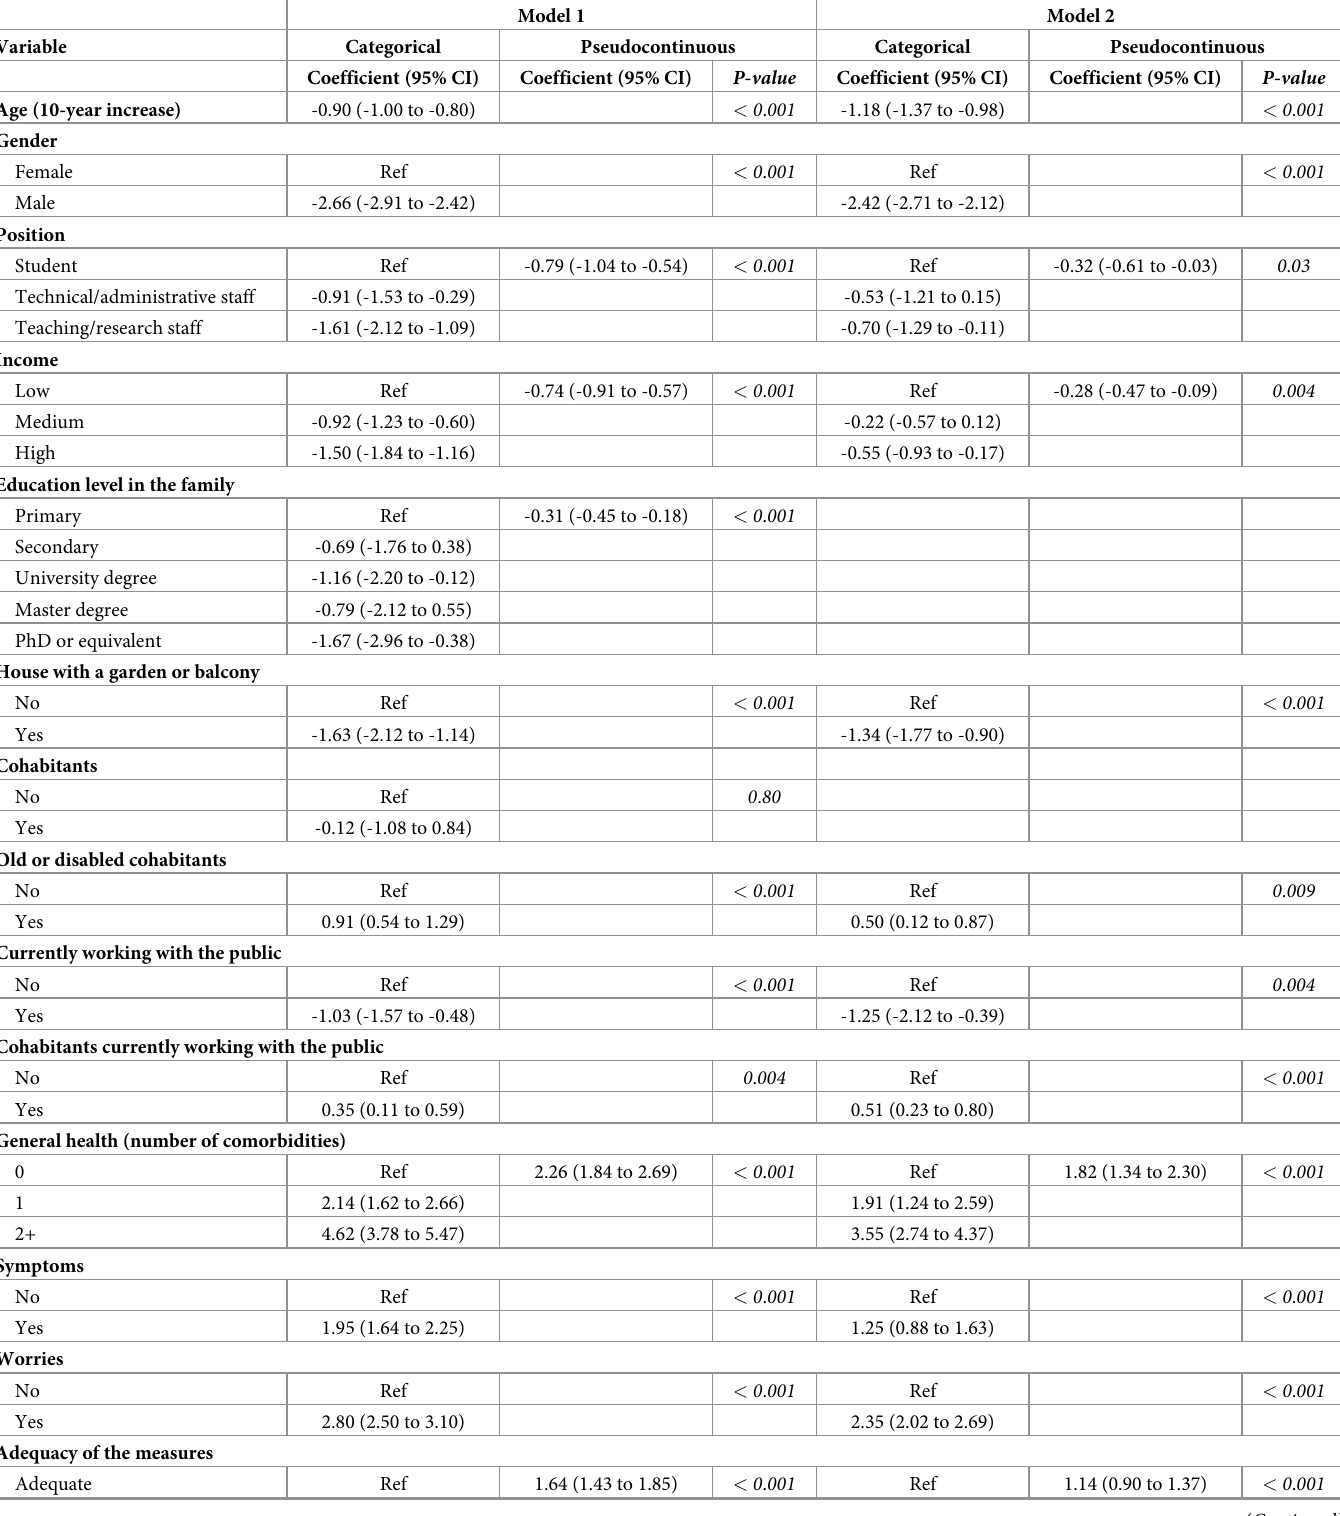
Table 2. Linear regression of